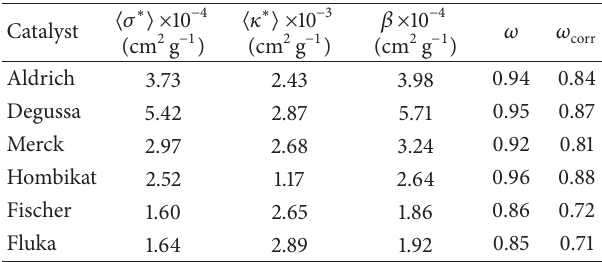
Table 2: Average optical properties of commercial photocatalysts based on titanium dioxide under solar